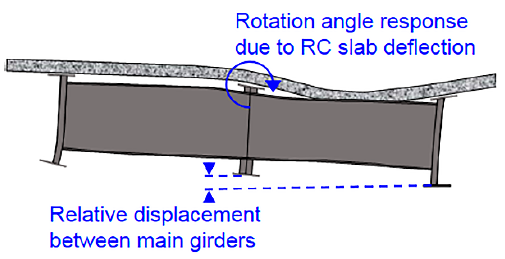
Figure 2. Example of the rotation angle response due to reinforced concrete (RC) slab deflection and relative displacement between main girders.